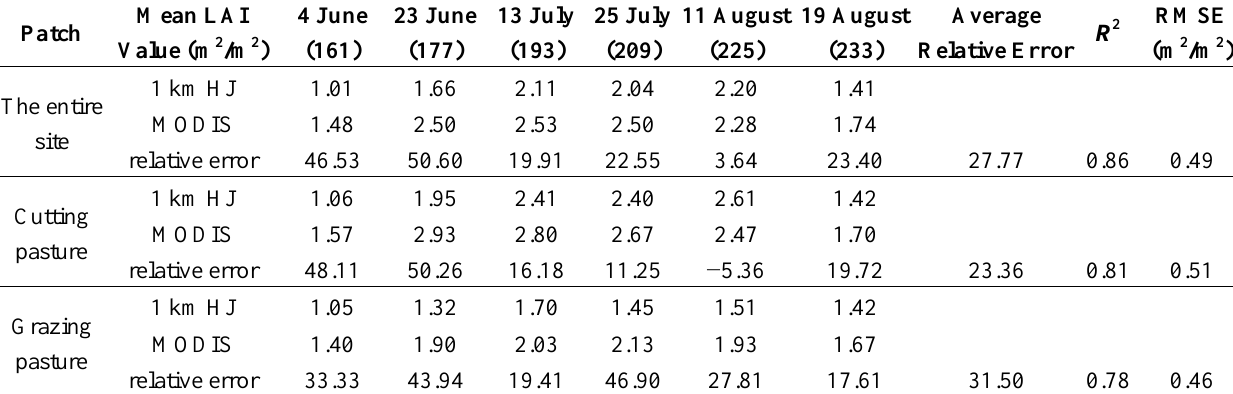
Table 3. Statistics of patch-by-patch comparison between the MODIS and aggregated HJ LAI